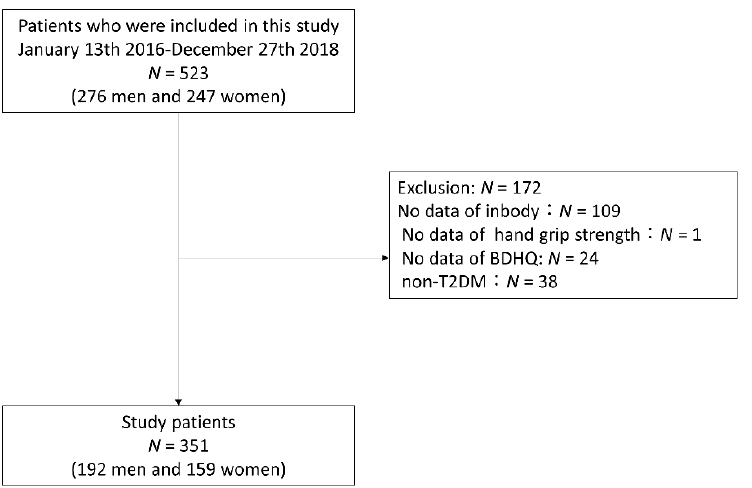
Figure 1. Inclusion and exclusion flow. BDHQ, Brief-type self-administered diet history questionnaire; T2DM, type 2 diabetes mellitus.